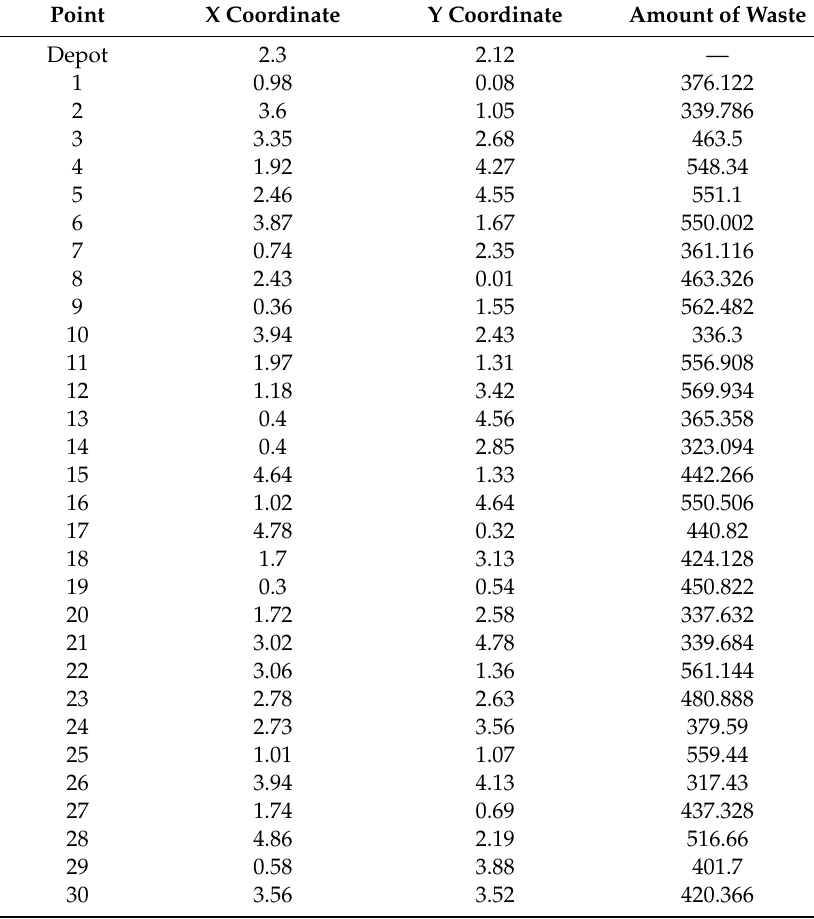
Table 6. Information about the Depot and Smart Waste Bins.